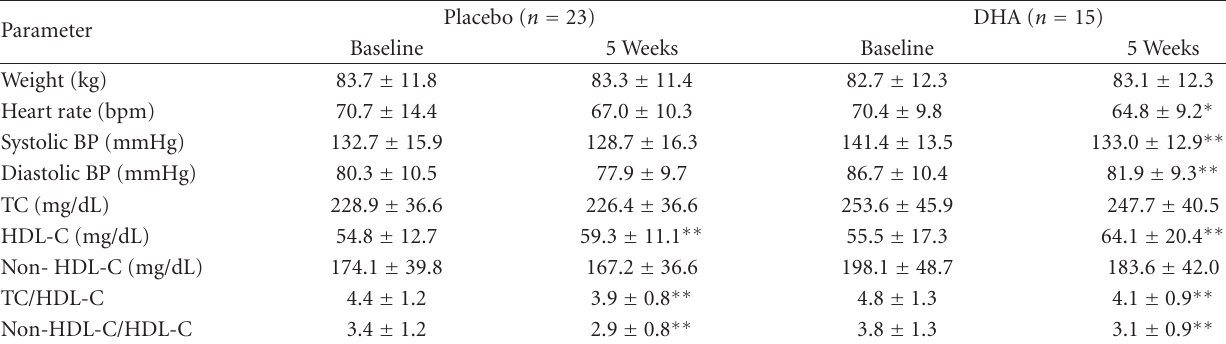
Table 4: Body weight, heart rate, blood pressure, and lipid profiles in the two groups at baseline and at 5 weeks. Placebo ( n = 23) Parameter